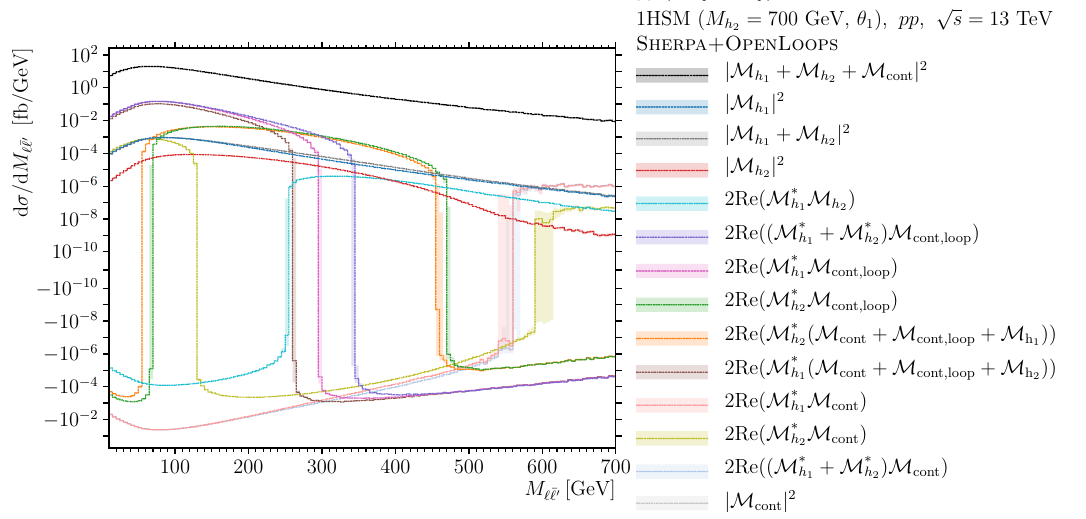
Figure 12 . M distributions for the signal process gg ( (cid:31) ¯ (cid:31) (cid:31) = 700 GeV, θ 1 ) including its interference with the background in pp collisions at √ s = 13 TeV. ( M h 2 Other details as in figure 10.